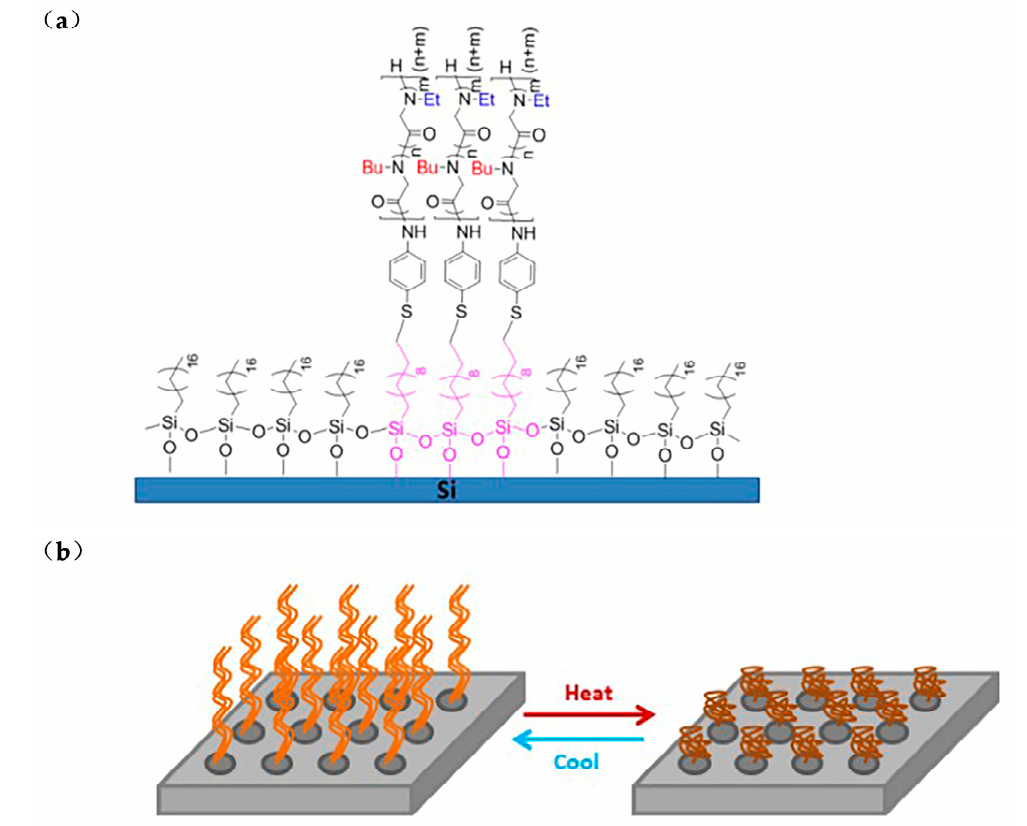
Figure 5. ( a ) Preparation of temperature-responsive copolypeptoids on silicon substrate; ( b ) the temperature-responsive polymer expands or collapses with the change of temperature. Reprinted with permission from [75]. Copyright 2019, American Chemical Society.